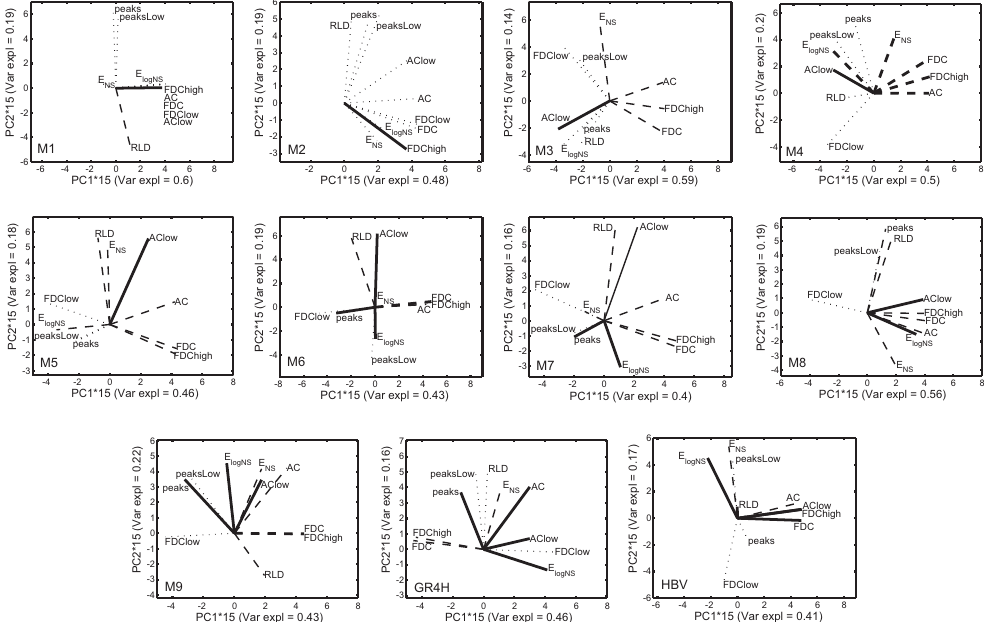
Fig. 9. Results for PCA for the Wollefsbach catchment. Each figure represents one of the model structures. The figures are based on 1000 parameter sets. The principal components are dimensionless, because the ratios of specific signatures of the modelled and observed hydrographs are used to construct the evaluation criteria and these ratios are dimensionless. The total variance explained by these figures is the sum of the explained variance per PC.